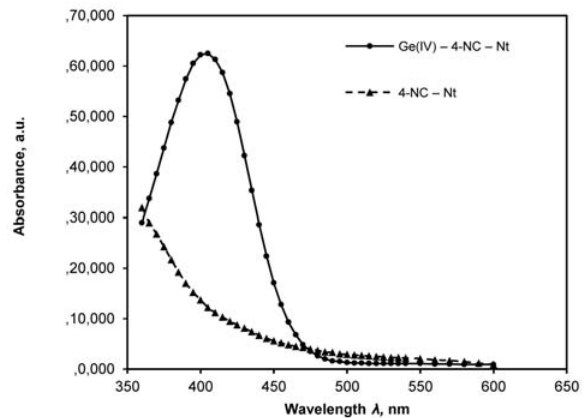
Figure 1. Absorption spectra of the complex Ge(IV)–4-NC–Nt and of the blank sample 4-NC–Nt in CHCl L –1 ; C = 5.0 × 10 –4 mol L –1 ; C 4-NC λ = 405 nm; τ = 2 min